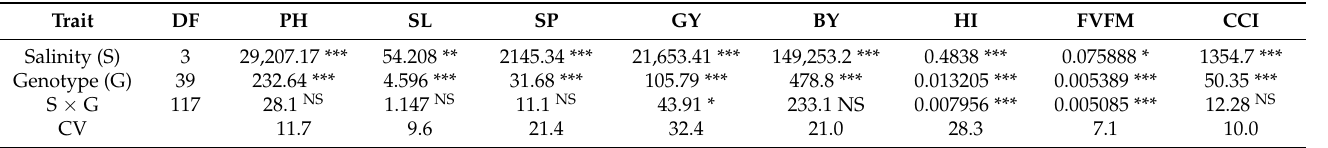
Table 5. Grain yield of control (GYN), grain yield at 8.0 dS/m (GY8), and salinity tolerance/suscep- tible indices of forty genotypes in 2019/20 season.